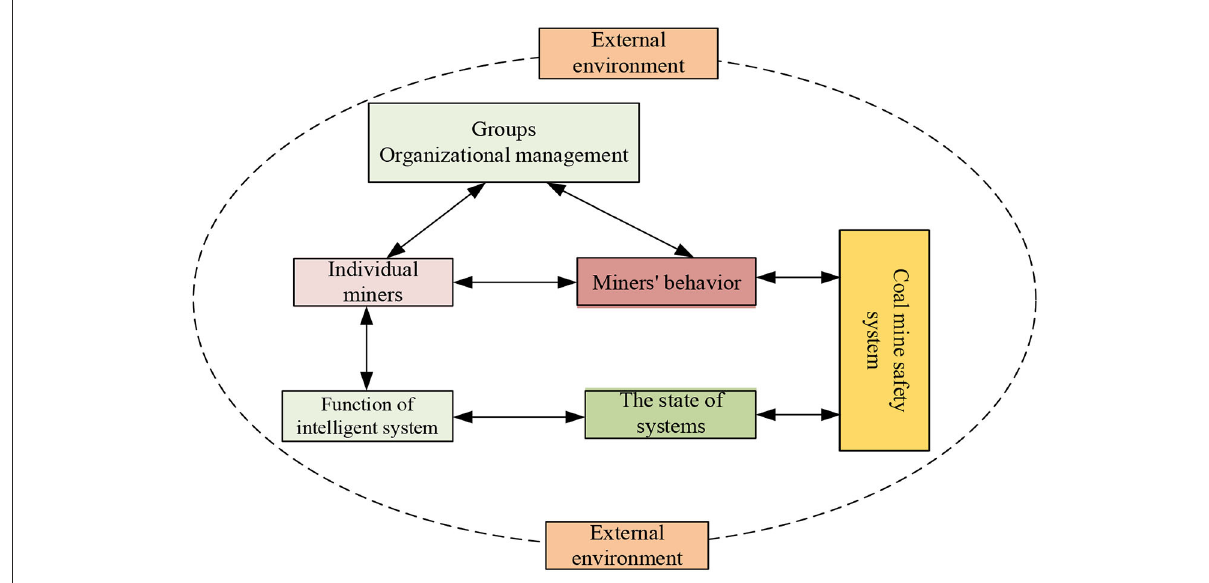
FIGURE2 Theoretical framework of coal mine safety